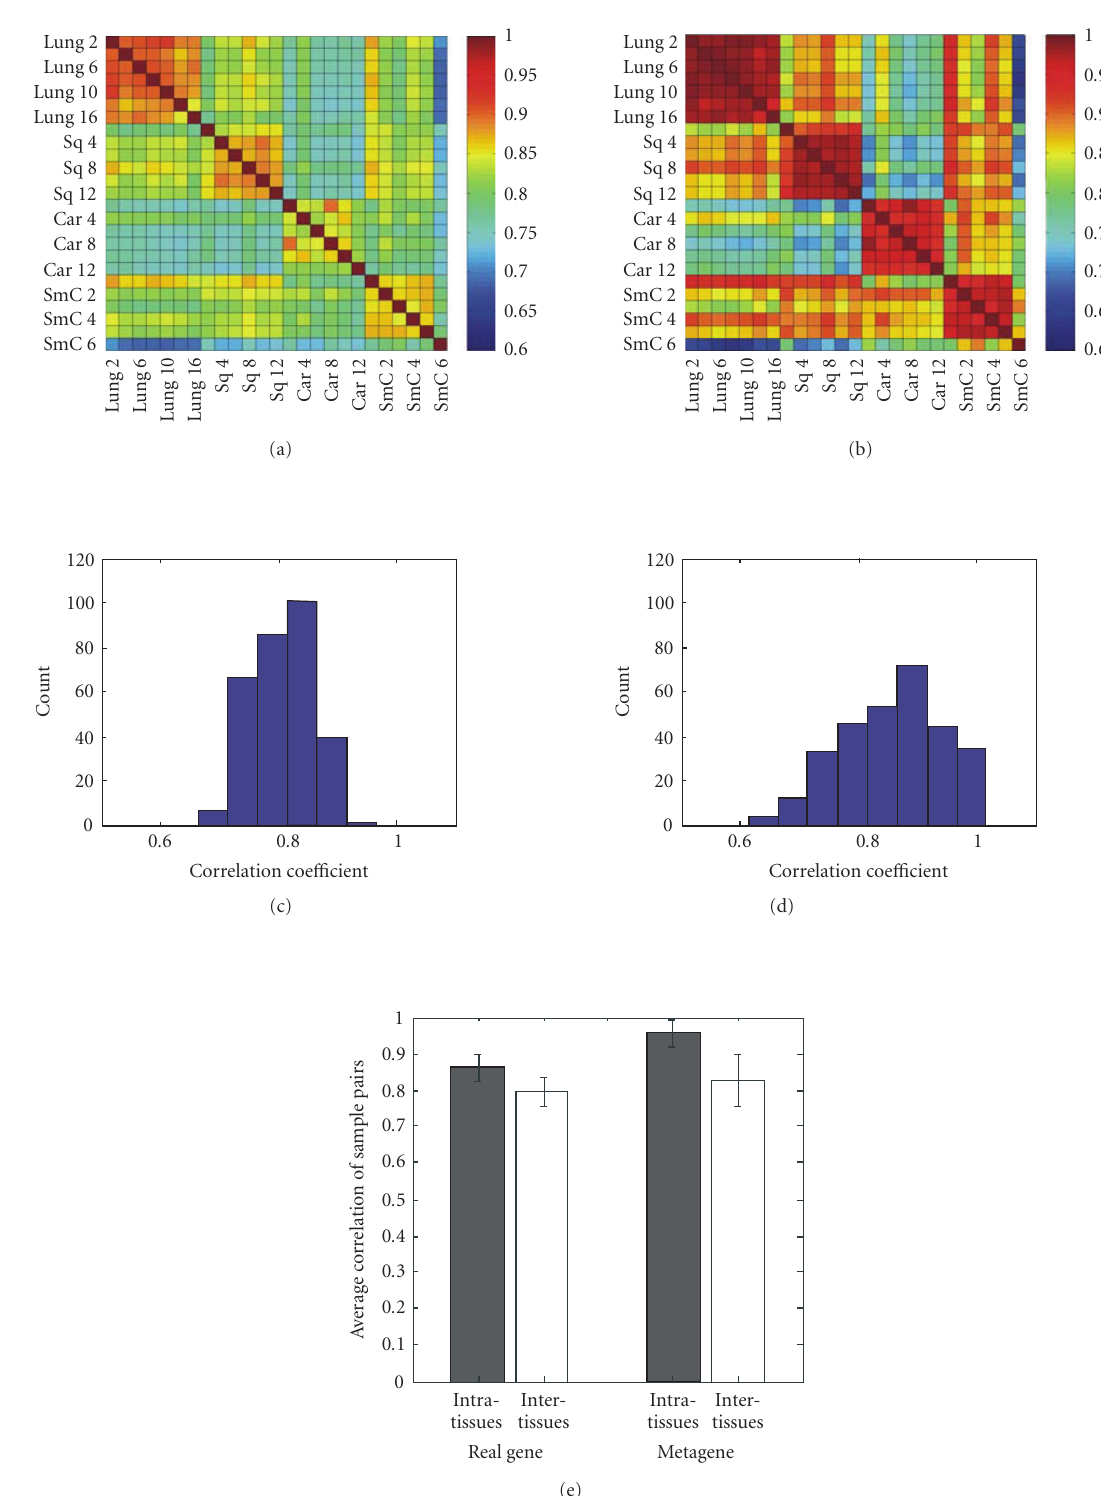
Figure 3: Correlation coe ffi cients of samples using simple gene approach or gene pattern approach. (a), (b) Matrix of correlation coe ffi cient values r jk for the correlation between all pairs of sample j versus k , based on “real” gene expression values (a) or metagene (centroid) values (b). (c), (d) Histograms of all the correlation coe ffi cient values from (a) (histogram (c)) and (b) (histogram (d)), respectively. (e) Average correlation of intra-tissues ( n = 66) and inter-tissues ( n = 234) sample pairs when real gene and metagene data are used,